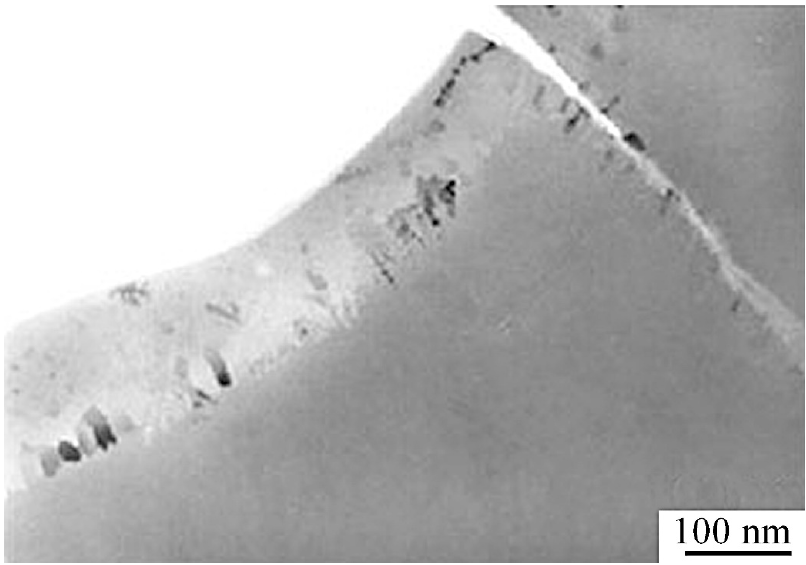
Figure 19. An initial part of the X ‐ ray diffraction pattern of Al88Ni6Y6 sample after deformation ( a ) and after deformation plus cryogenic cycling ( b ): (1) experimental spectrum, (3,4) diffuse reflections corresponding to 2 amorphous phases, (5) (111) Al nanocrystal reflection, (2) sum of 3–6 lines [reproduced from Mater. Let. 2019, 240, 159 with permission from Elsevier, 2020] [146].